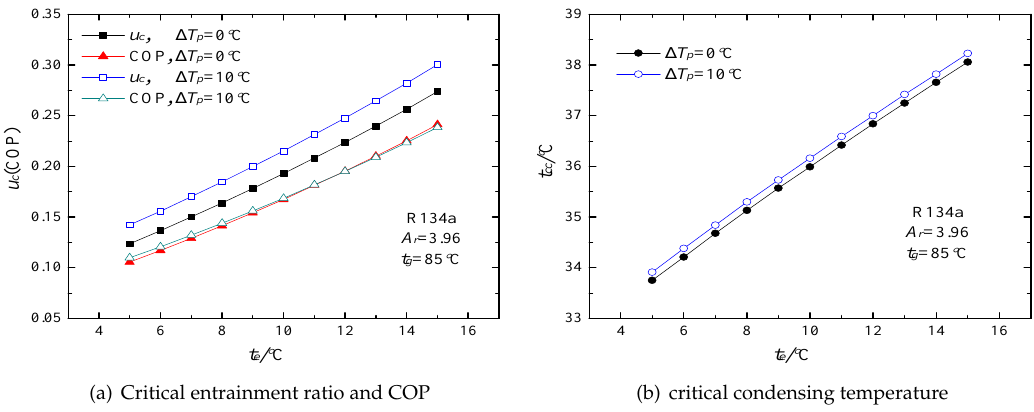
Figure 19. Critical entrainment ratio, COP and critical condensing temperature versus evaporating temperature using R134a as a working